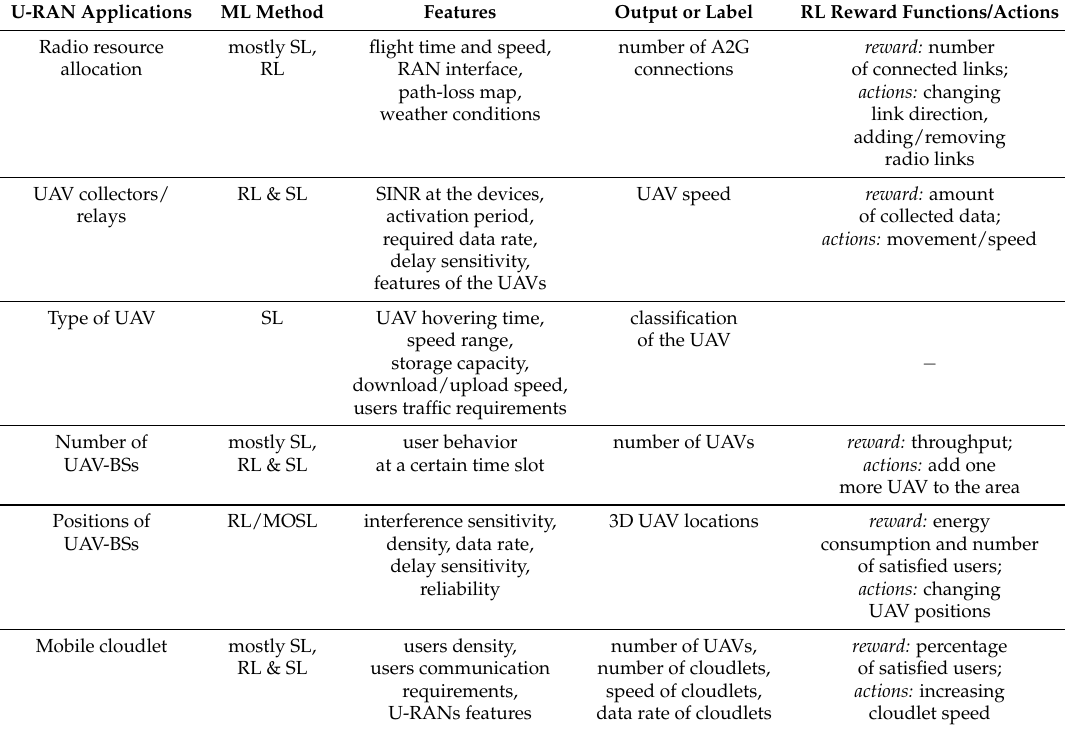
Table 2. A summary of U-RAN applications where ML-based methods can be